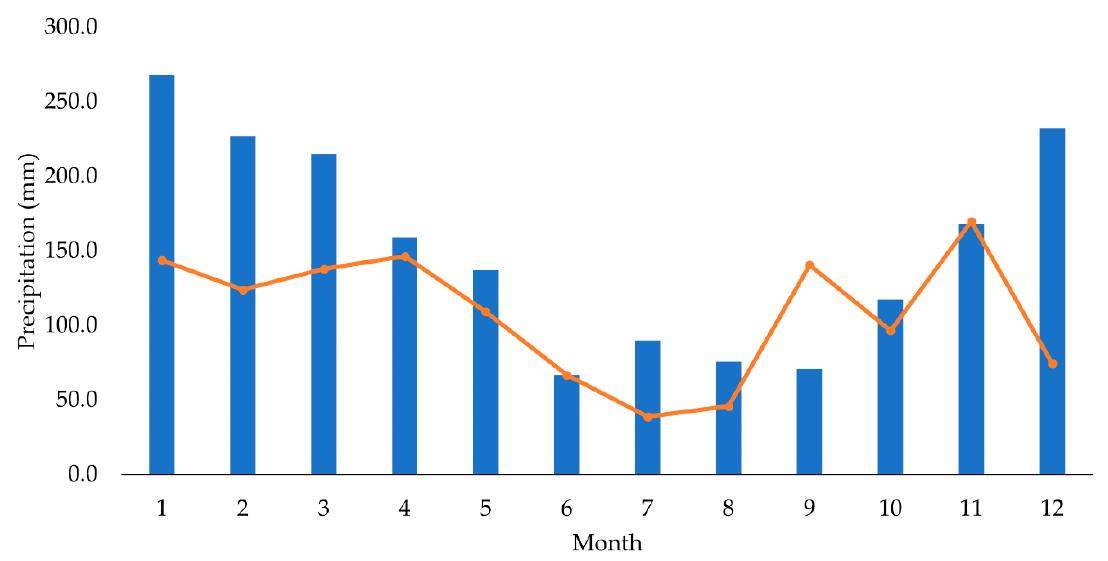
Figure 3. Long-term 17-year mean precipitation (bars) and monthly precipitation for 2016 (line); source from Batutegi Dam station, Directorate General of Operation and Maintenance Water Resources Mesuji Sekampung (DGOMWRMS) [23].